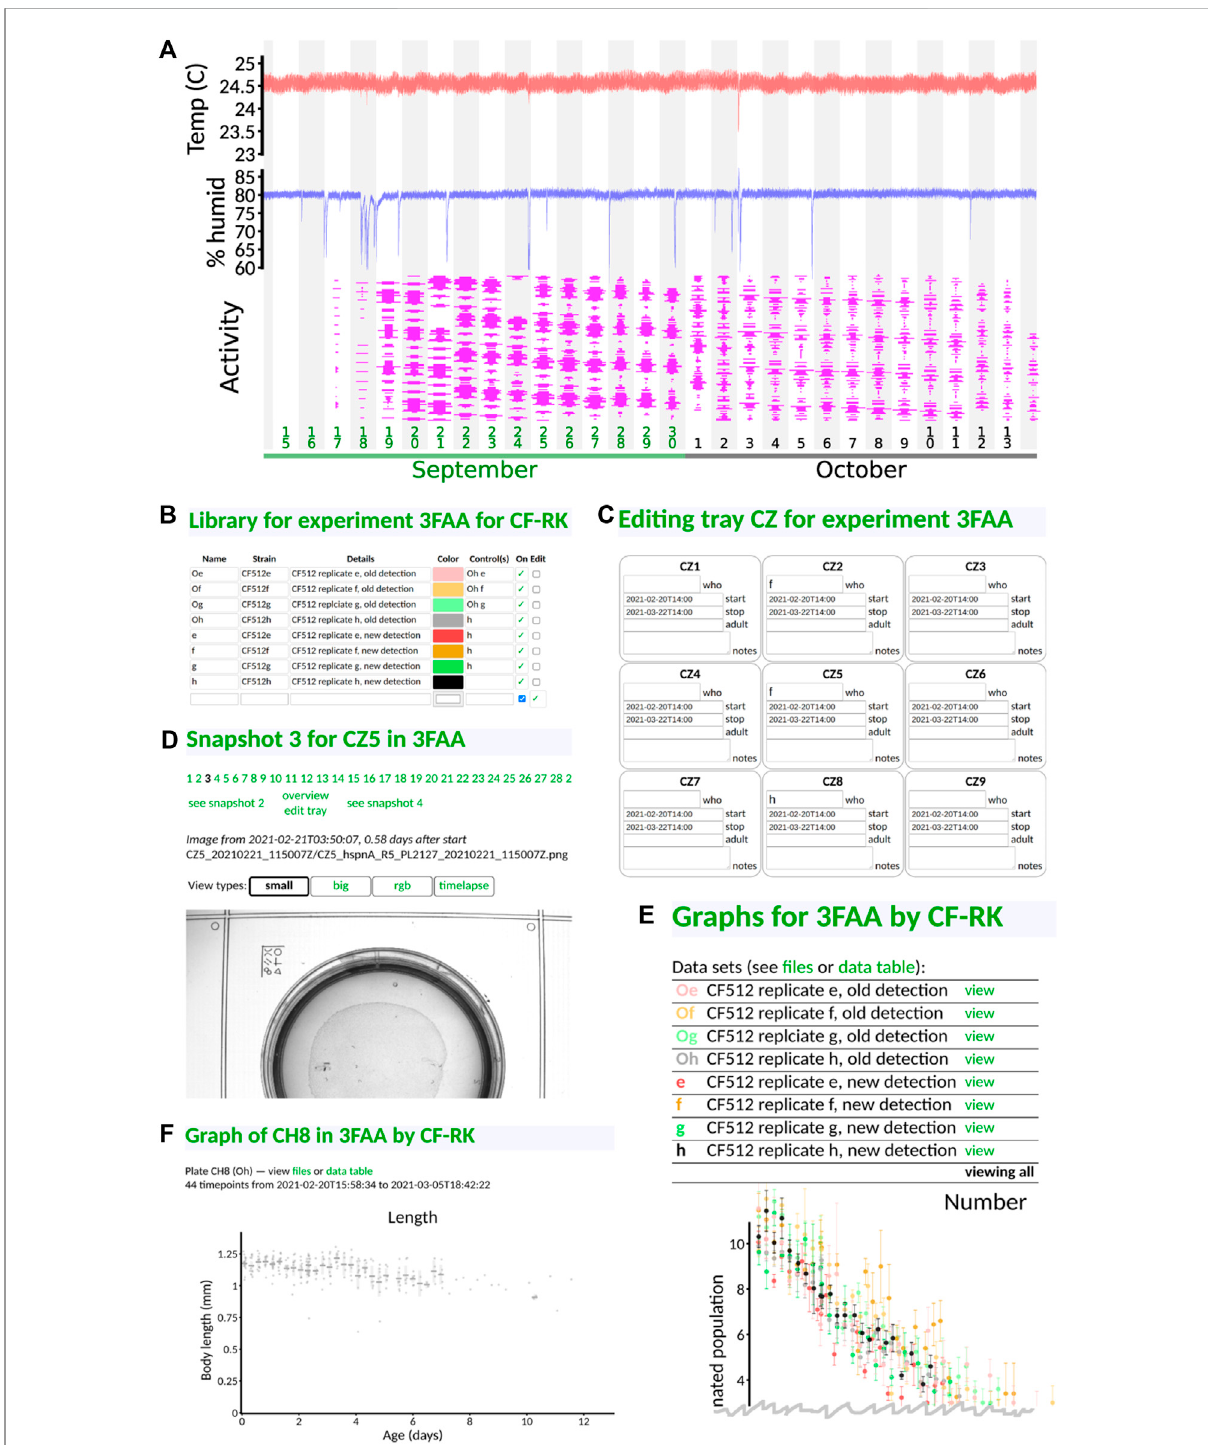
FIGURE 4 Web-baseduserinterface.Allpanelstakendirectlyfromtheinterfacewithnoeditingsavecropping. (A) Frontpagestatusmonitoring.Userscan seeataglancetemperature(red),humidity (blue), and instrument utilization (magenta;width indicates thefractionofeach tray fi lled with plates, and timethroughoutthedayrunsfromlowtohigh).Downwardspikesinhumidityarecausedbyopeningtheincubatorto,forinstance,loadsamples. (B) Library de fi nitions. Users can give nicknames and colors to their samples, in addition to specifying strains and condition information. (C) Assignment of samples to tray positions. Only the sample nickname is required, and only in plates that exist; dates are auto-populated from experiment-levelmetadata. (D) Visualcheckingofsnapshots.Usersmayseesnapshotsofanyrecordedplateinorderto,forinstance,checkformold